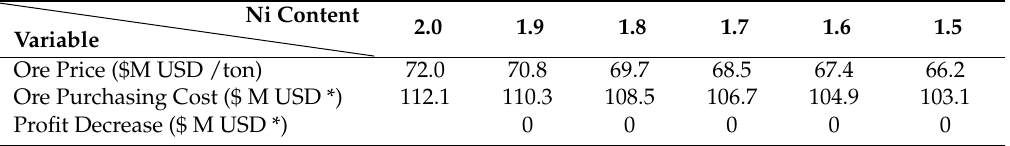
Table 7. Cost and profit with Fe content variation (fluctuating price